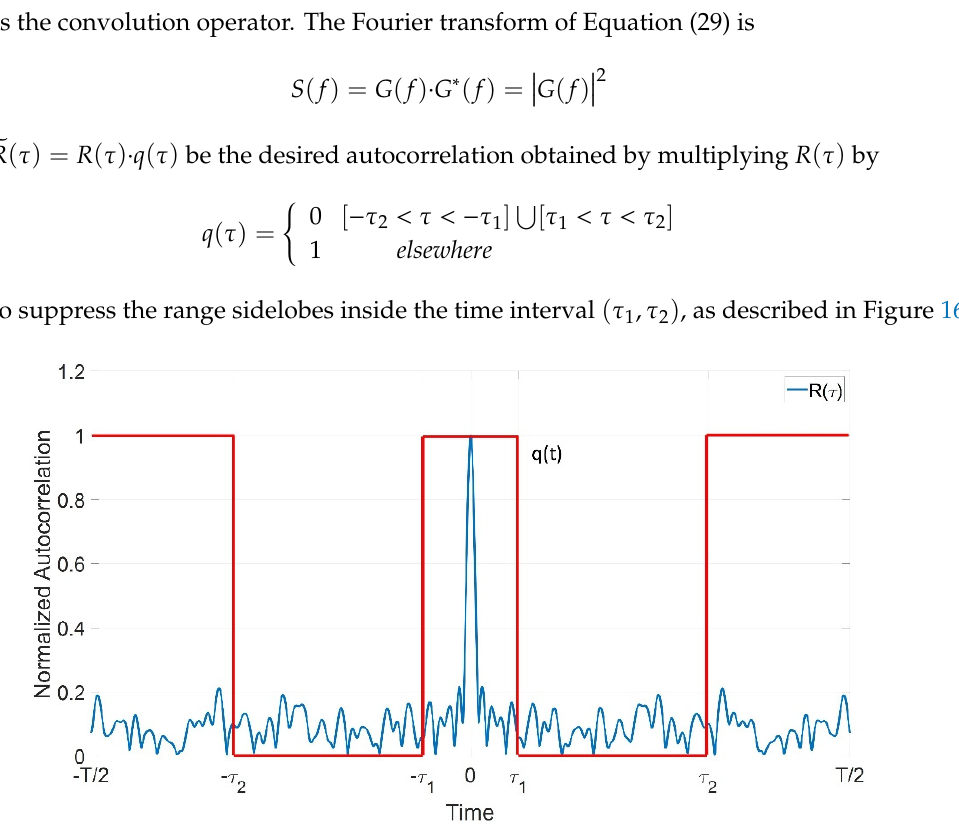
Figure 16. The sidelobes suppression interval as defined by q ( τ ) , red